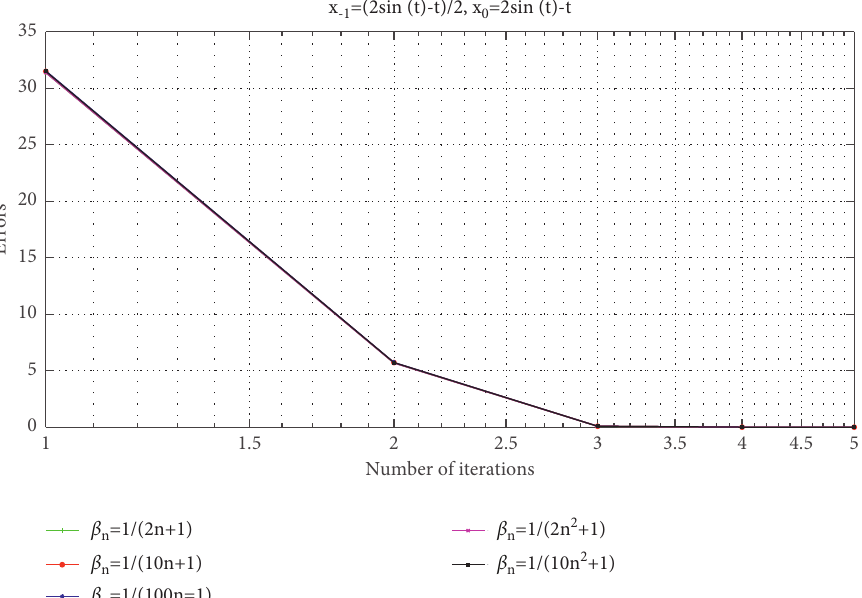
Figure 11: The Cauchy error plotting number of iterations for different parameters β